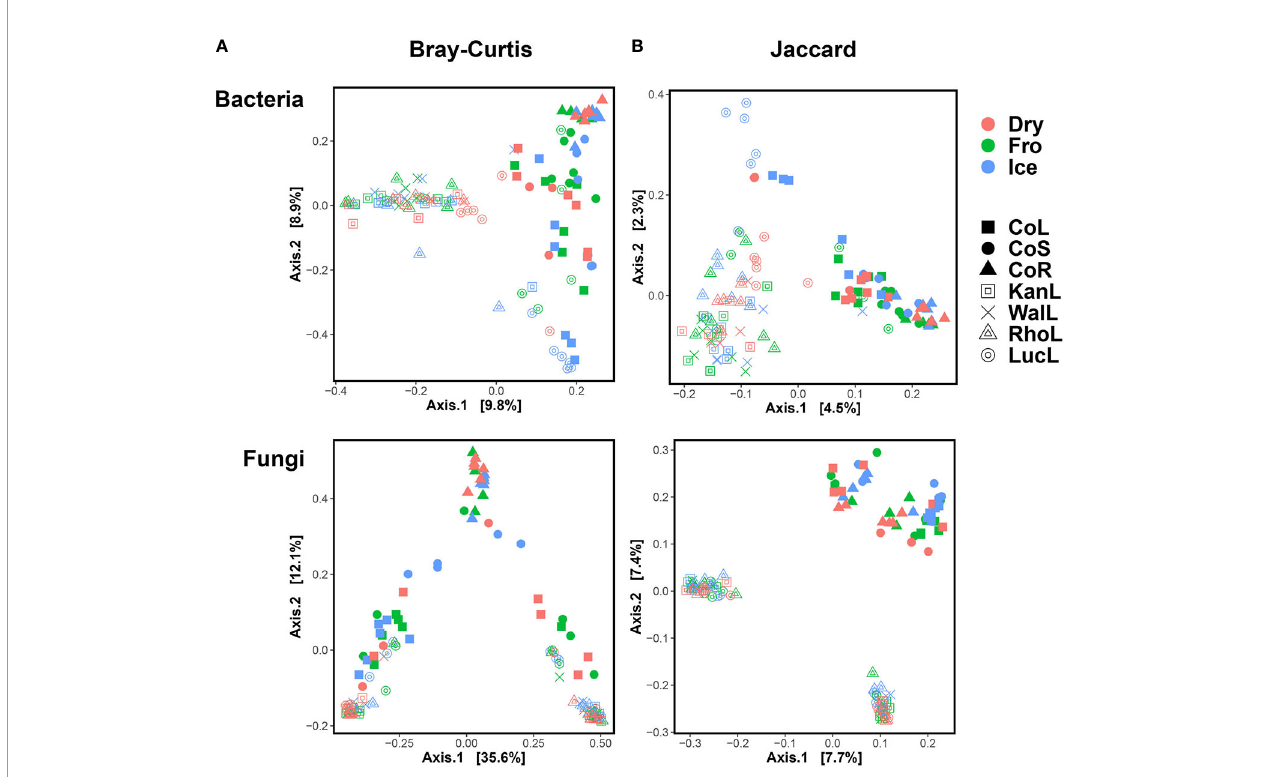
FIGURE 2 | Principal Coordinates Analysis (PCoA) plot using Bray – Curtis and Jaccard distance matrix on bacterial (A) and fungal (B) communities under different preservation methods. Dry = air-dry (red), Fro = snap freezing (green), Ice = ice incubation (blue). CoL = cotton leaf (solid square), CoS = cotton stem (solid circle), CoR = cotton root (solid triangle), KanL = kangaroo leaf (open square), WalL = wallaby leaf (cross), RhoL = rhodes leaf (open triangle), LucL = lucerne leaf (open